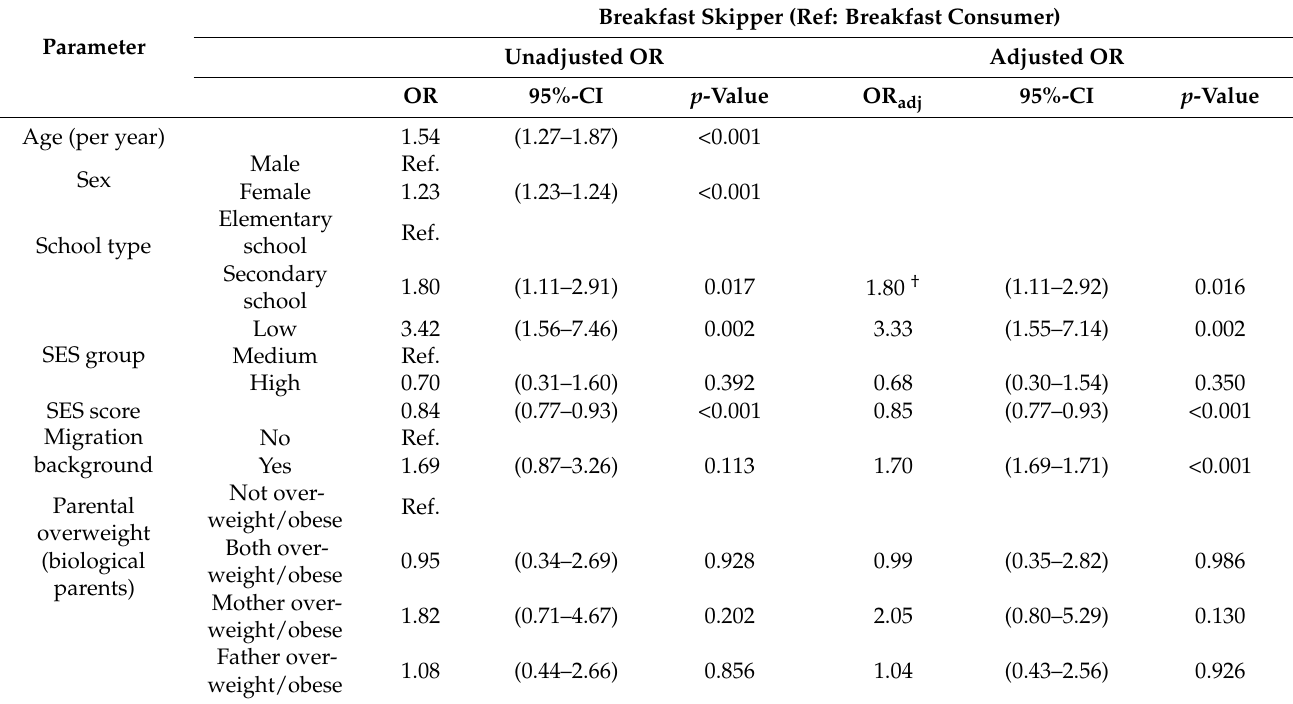
Table 2. Associations between regular breakfast skipping ( n = 72) and different dependent variables. Effects are given as odds ratios (incl. 95% CI) for the unadjusted and the adjusted